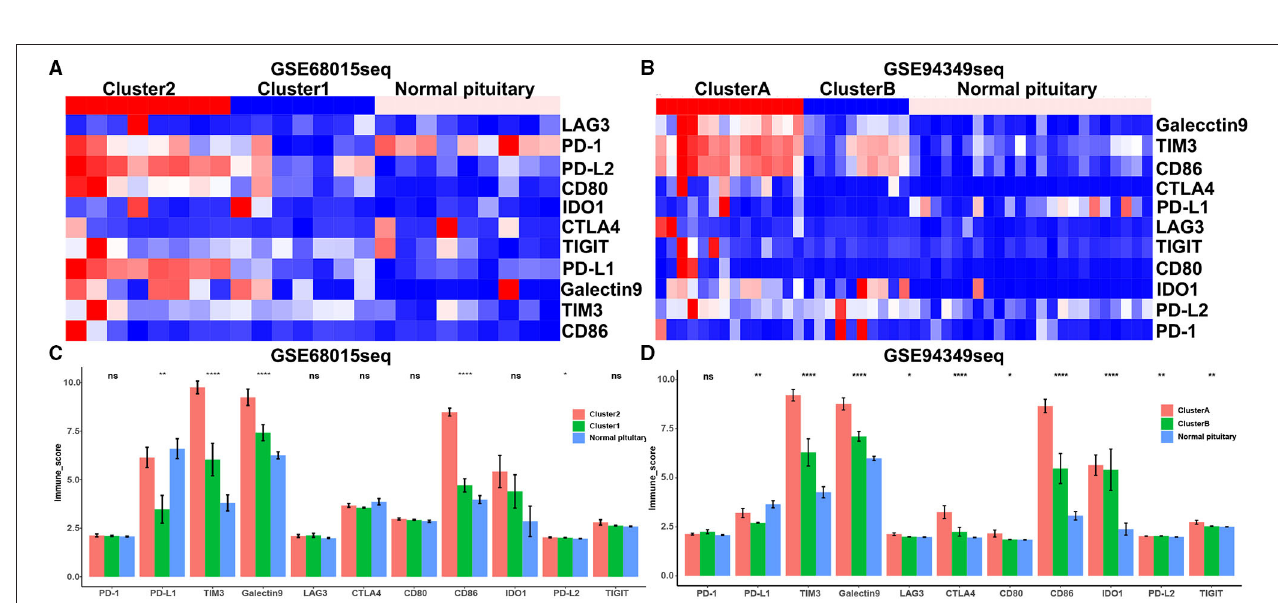
FIGURE 6 | Expression of immune checkpoint molecules in the IG and IR subtypes of ACPs. (A,B) Heat map displaying the distribution of immune checkpoint molecules (PD1, PDL1, PDL2, TIM3, CTLA4, Galectin9, LAG3, and CD86) among cluster 1/2, cluster A/B and normal pituitary groups in the GSE68015 and GSE94349 databases. (C,D) The bar chart showed the ratio differentiation of immune checkpoint molecules among cluster 1/2, cluster A/B and normal pituitary groups. *p < 0.05,**p < 0.01, ****p < 0.0001.